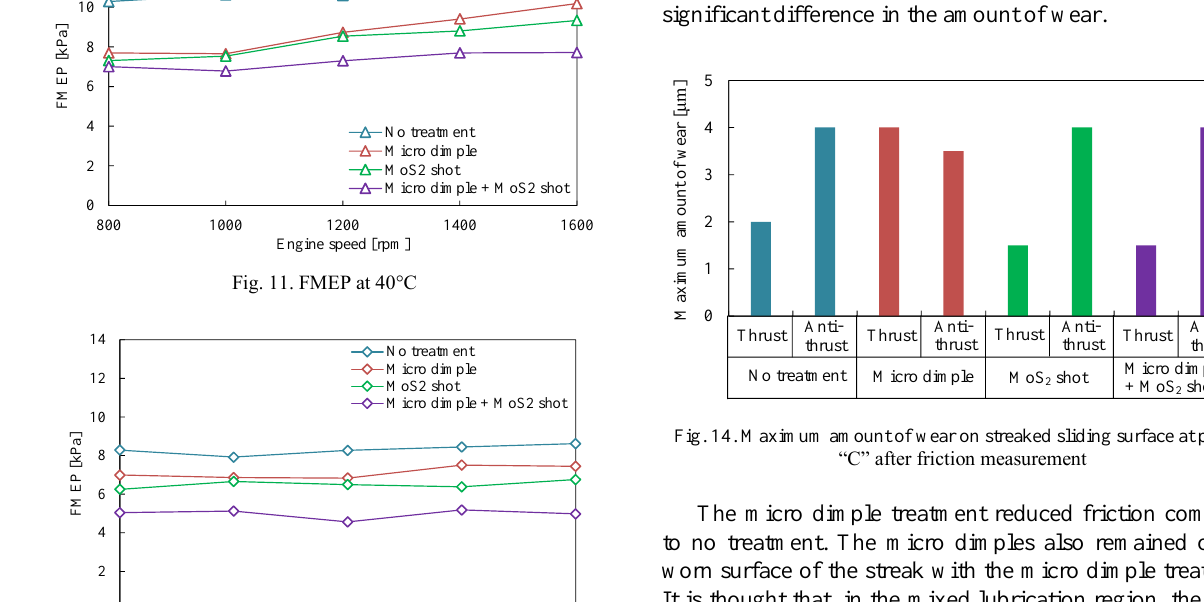
Fig. 14. Maximum amount of wear on streaked sliding surface at part of “C” after friction measurement The micro dimple treatment reduced friction compared to no treatment. The micro dimples also remained on the worn surface of the streak with the micro dimple